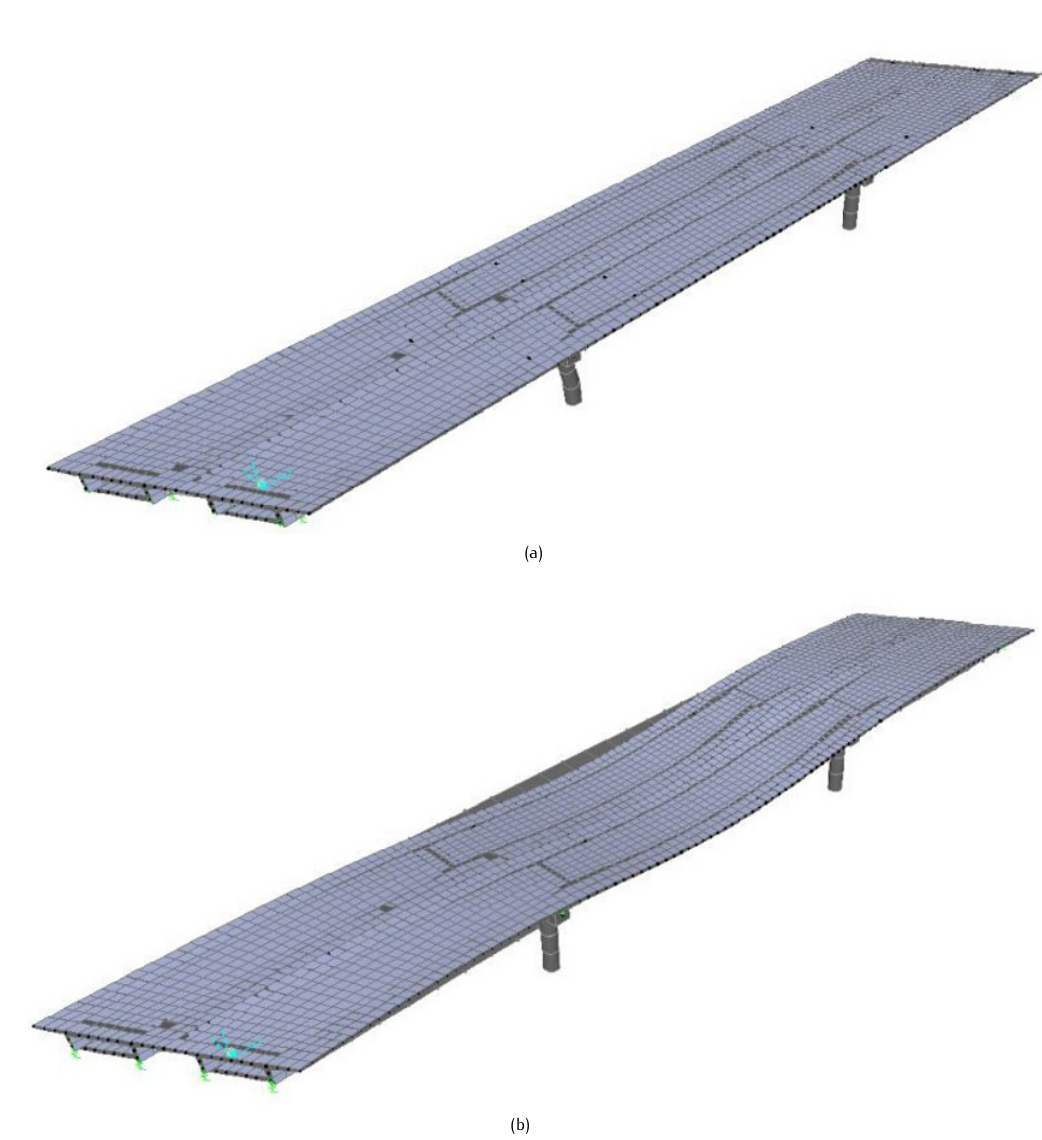
Figure 16. The mode shapes of modal after strengthening: (a) mode No.1, (b) mode No.2